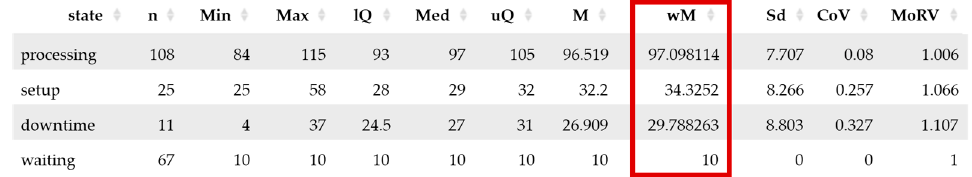
Figure 14. Example of the results adjusted for extreme outliers in test series one, wherein the weighted means are marked in color.